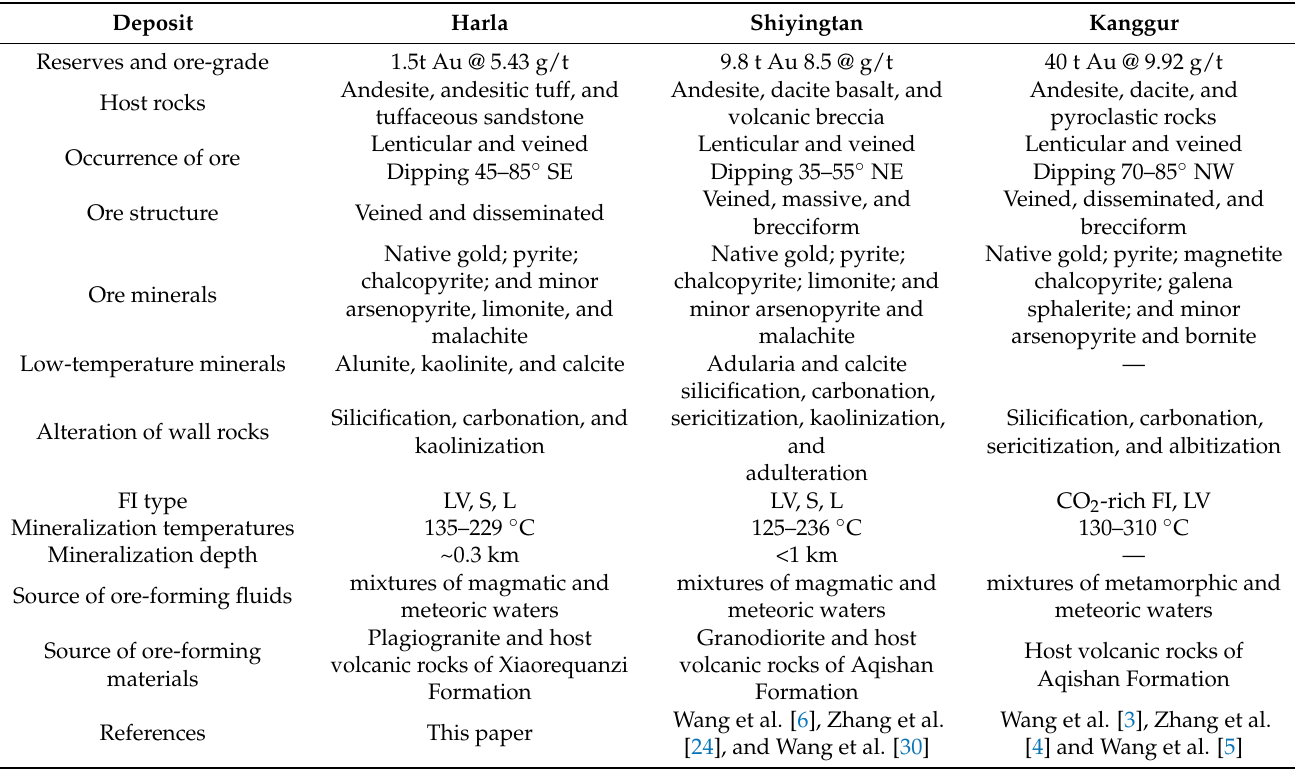
Table 4. Comparison of features of Harla gold deposit and other typical gold deposits in